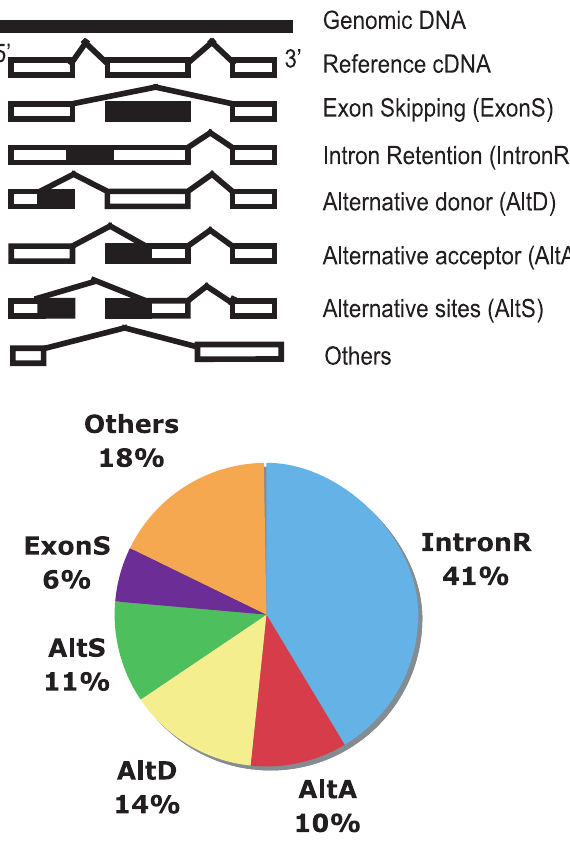
Figure 1. Transcript structure variations of Anophelesgambiae mosquitoes. Upper panel is a diagram illustrating the variation types. White boxes are exons in mRNA, and black boxes are parts of exons in some mRNA and parts of introns in others. The sites connected by lines are splicing sites. The ‘‘Others’’ type includes alternative transcript initialization, major gene structure changes or types that cannot be summarized by the other five categories. Lower panel shows the frequency distribution of transcript structure variation types in A. gambiae .